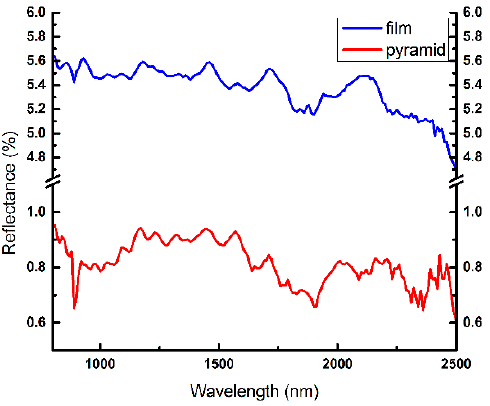
Figure 6. Reflectance curves for 5.49 μ m thick SiN x layers and the measured micro-pyramid